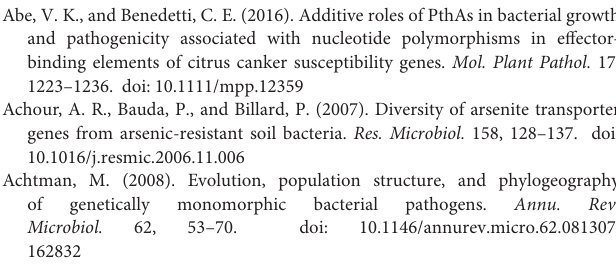
Supplementary Figure 6 | Pairwise comparison of plasmids. Upper panel: copper resistance plasmids. Lower panel: pathogenicity related plasmids. Blue line: syntenic region in the same direction. Green: syntenic region in the reverse direction. Orange: secondary alignment. a. plasmids sequenced in this study. Supplementary Figure 7 | Estimated plasmid copy number based on the Nanopore sequencing coverage. Supplementary Figure 8 | Multiple plasmid alignment of pXAC33, pXAC64 and non-CuR plasmids sequenced in this study. (A) Mauve alignment including pXAC33, pxAC64 and plasmids in this study. (B) Mauve alignment of plasmids in this study. Syntenic regions share the same color. Supplementary Figure 9 | Genome assembly confirmation of the copper-resistance plasmid pT4p2. (A) Genome structure of the 40 kbp inverted repeat. (B) PCR product of the PF1-CF1 primer pair and (C) PCR product of the PF1-CR3 primer pair. Supplementary Figure 10 | Inverted duplication of metal-resistance clusters between pT4p2 and pLH3.1. Orange box (Cop): location of copper resistance gene clusters. Pink box (Ars): arsenate-resistant gene clusters. Tns: transposase. Supplementary Figure 11 | Comparison of plasmids containing copper resistance genes in pT4p2, pCur and pLH201.1. Circles from outermost to innermost represent: (1) position and genes, the grid is 10 kbp [pink, pT4p2 of strain T4; yellow, pLH201.1 (NZ_CP018859.1) of strain LH201; white, pCuR (NZ_CP023286.1) of strain 03-1638-1-1]; (2) GC content with 2000-bp sliding window and 200-bp step; (3) regions with similar gene content and nucleotide sequence identity > 90%, and alignment length > 1 kb between plasmids. Supplementary Figure 12 | Multiple sequence alignment of csd1 and cas8c genes. Black box, around 530 nt, indicates the AG frameshift. Supplementary Table 1 | Summary of assembly and annotation statistics. Supplementary Table 2 | Strains used for pan-genome analysis. Supplementary Table 3 | Pairwise nucleotide sequences identified by fastANI. Supplementary Table 4 | GO enrichment of strain specific genes. Supplementary Table 5 | Gene clsters of the type II and type III secretion systems. Supplementary Table 6 | TALEs and repeat number of RVDs in plasmids. Supplementary Table 7 | Strains used for copper and arsenate resistance gene cluster alignment. Supplementary Table 8 | Strains containing the unique spacer repeat between the copper and arsenate resistance gene clusters. Supplementary Table 9 | Conjugation frequency of plasmid-borne copper resistance genes transferred between different Xanthomonas citri subsp. citri strains in vitro